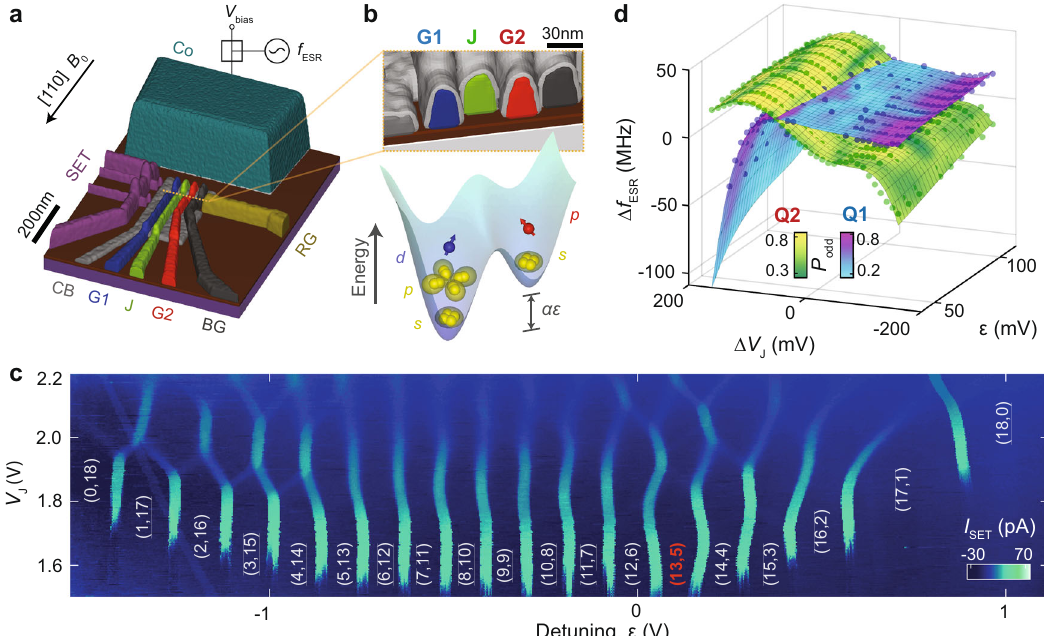
Fig. 1 Device overview and electron occupancy measurement. a A 3D visualization of the Si-MOS device structure. A quantum dot is formed under gate G1 (blue) and G2 (red), with inter-dot tunnel rates controlled by J (green). Gate RG enables connection to an n -doped reservoir to load/unload electrons to/from the quantum dot, with tunnel rates controlled by BG. Gate CB serves as a con fi nement barrier in lateral direction. The cobalt structure at the top of the image acts as both a micromagnet and electrode for EDSR control (dark green), where a DC voltage bias V bias and a microwave signal with frequency f ½ 1 (cid:1) 10 (cid:2) crystallographic direction, indicated by the orange dashed line. Bottom: schematic showing ESR is applied. b Top: cross-section diagram of a along the the number of electrons in each of the two quantum dots, aligning with the metal gates in the panel above. The height of each electron represents its relative energy and the shell to which it belongs, with inter-dot detuning energy αε . Each orbital is labelled correspondingly. Yellow electrons form full shells and are inert, while the extra electron in each dot (blue and red) act as an effective single spin qubit. c Charge stability map of the double quantum dot at B = 0 T, showing the charge occupancies ( N N I ε and V 0 1 , 2 ), produced by plotting the lock-in signal from SET sensor SET as a function of detuning J . The detuning ε = V G1 − V G2 is referenced by ε = 0 V at the charge readout transition (12,6) ⇔ (13,5). A square wave with peak-to-peak amplitude of 2 mV and frequency 487 Hz is applied to G1 for lock-in excitation. Dynamic compensation is applied to the SET sensor to maintain a high readout sensitivity. d Resonance frequency Δ f ESR of Q1 and Q2 as a function of ε and Δ V J = V J − 1.58 V when a microwave control pulse of frequency f MW = 30.486 GHz + Δ f ε and Δ V Δ f (cid:1) (cid:3) MW is applied. Each data point at any given J registers the MW when the adiabatic inversion probability is maximized for each qubit, i.e., when (cid:1) Δ f = Δ f ## . Colour scale represents the adiabatic inversion MW ESR . The qubits are initialized as